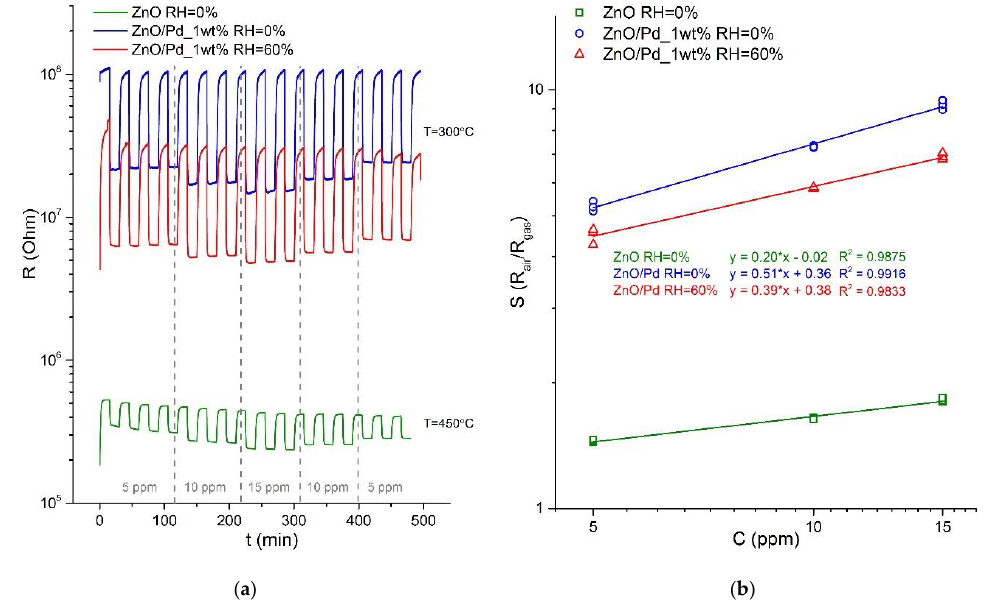
Figure 7. Transient sensor response ( a ) and calibration curves ( b ) for CO detection for ZnO and ZnO/Pd nanofibers at T = 450 °C and T = 300 °C, respectively, in dry (RH 25 = 0%) and humid (RH 25 = 60%) conditions.